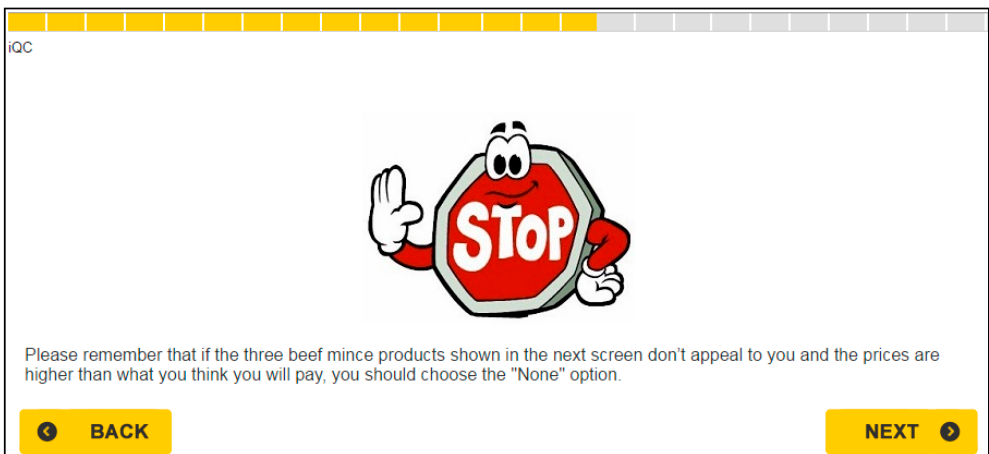
Figure 3. The opt-out reminder that was shown to respondents before each choice set.